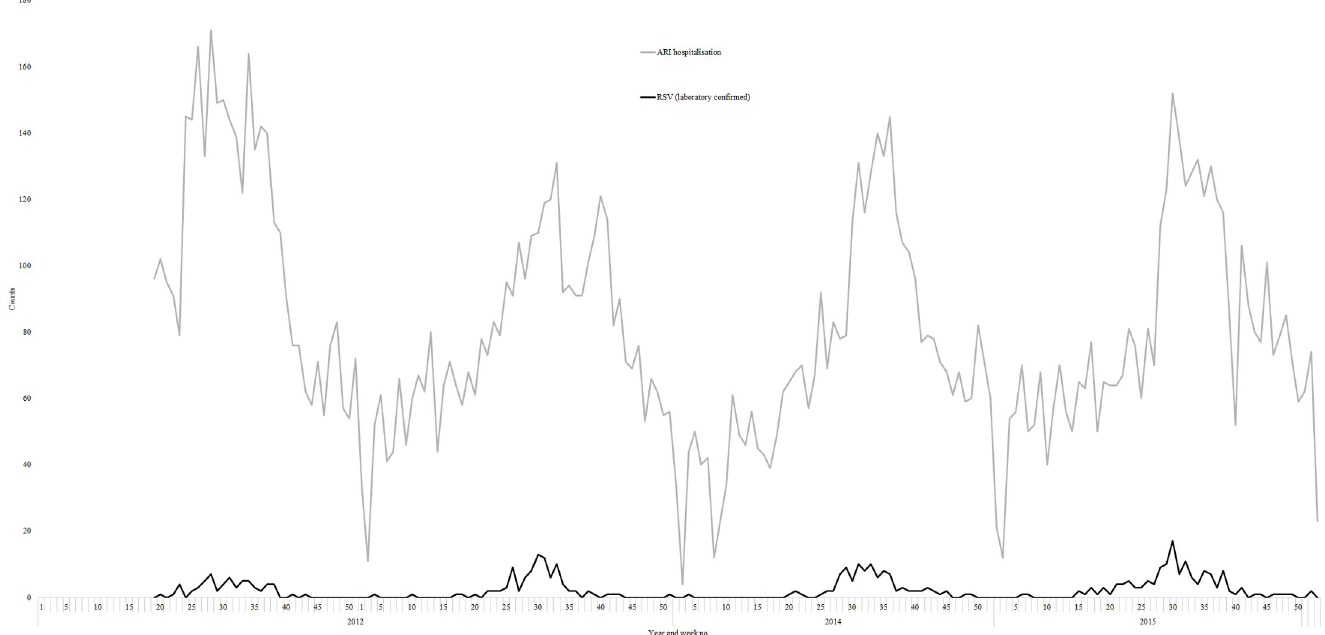
Fig 1. Weekly counts of acute respiratory infection (ARI) hospitalizations and respiratory syncytial virus (RSV) laboratory-confirmed hospitalizations among adults aged 50 years or older in Auckland, New Zealand,